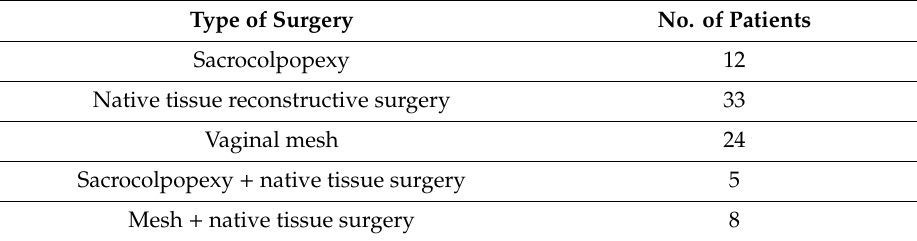
Table 2. Types of POP (Pelvic organ prolapse.) repair in the study group.